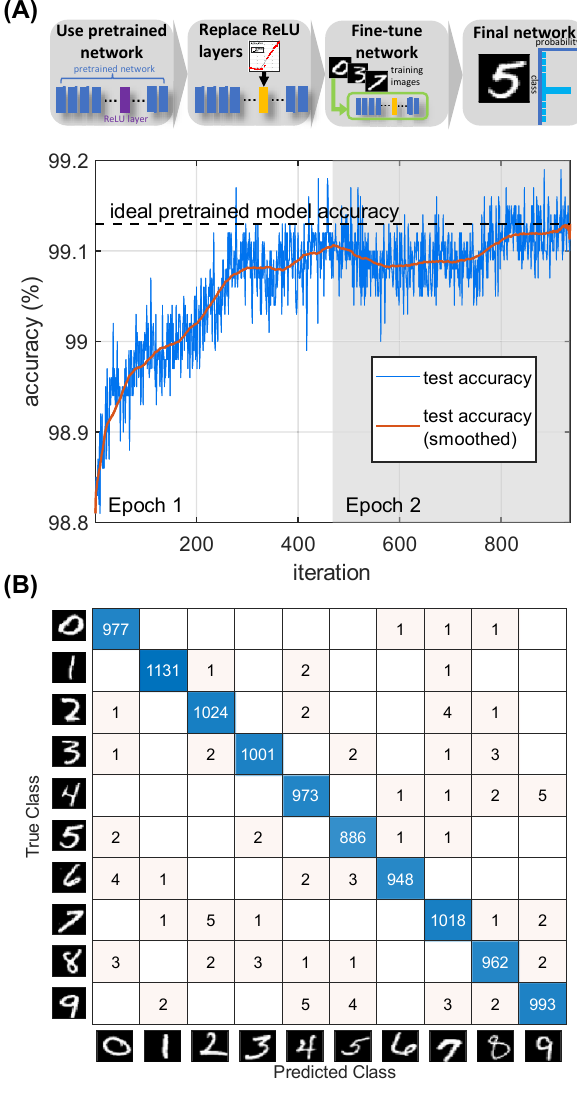
Figure 6: Simulated deep learning performance of the experimentally measured all-optical ReLU function for MNIST handwritten digits image classification. (A) A pretrained CNN was used where the ideal ReLU layers are replaced with custom layers representing the experimentally measured ReLU response (after shifting/scaling) then fine-tuned by training for 2 epochs (batch size of 128) to improve the test accuracy (blue line) back to the ideal pretrained model accuracy (dashed black line). (B) Confusion matrix on the MNIST task for the final network, which achieved 99.13 % test